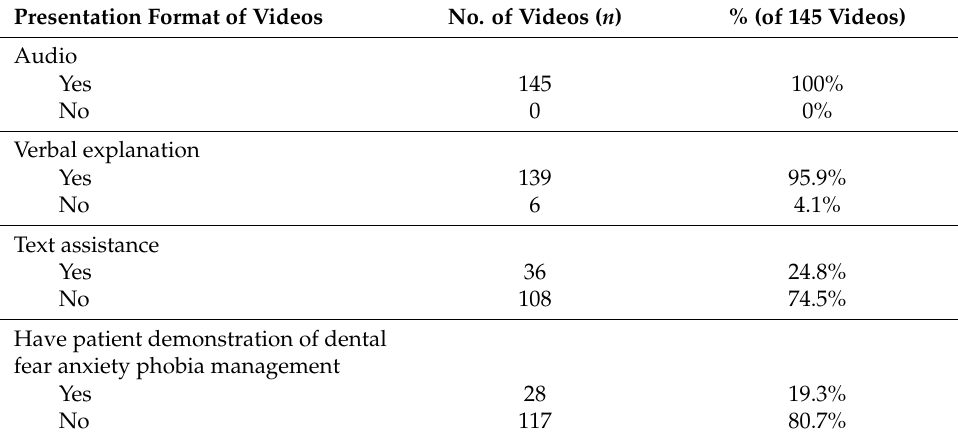
Table 10. Presentation format of videos.